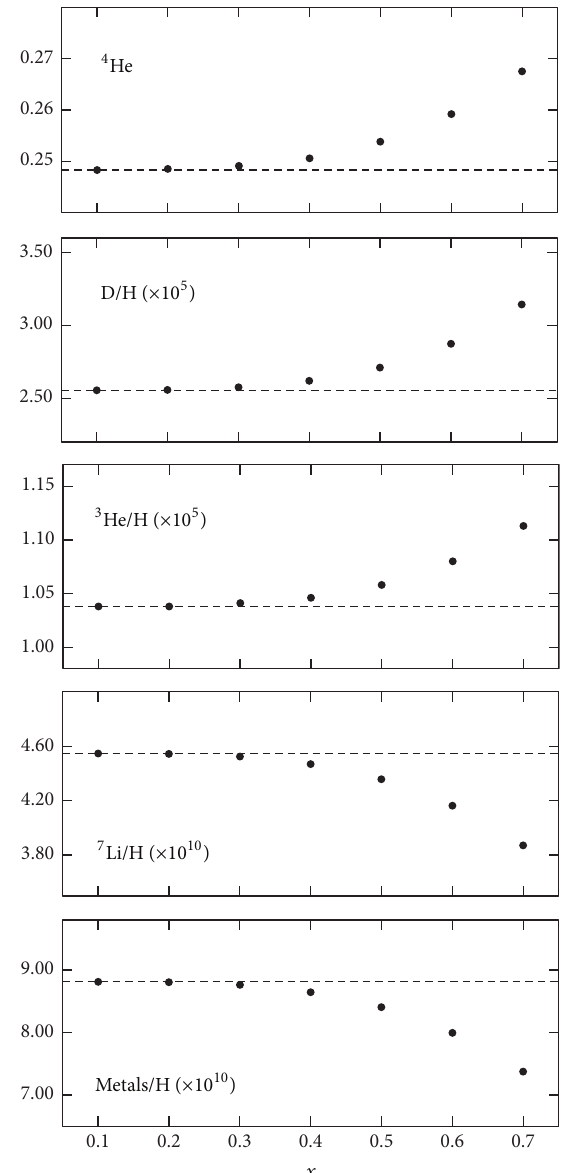
Figure 1: Primordial abundances of ordinary 4 He, D, 3 He, 7 Li, and metals (elements heavier than 4 He) for several values of 𝑥 and compared with the predictions of the standard model (dashed